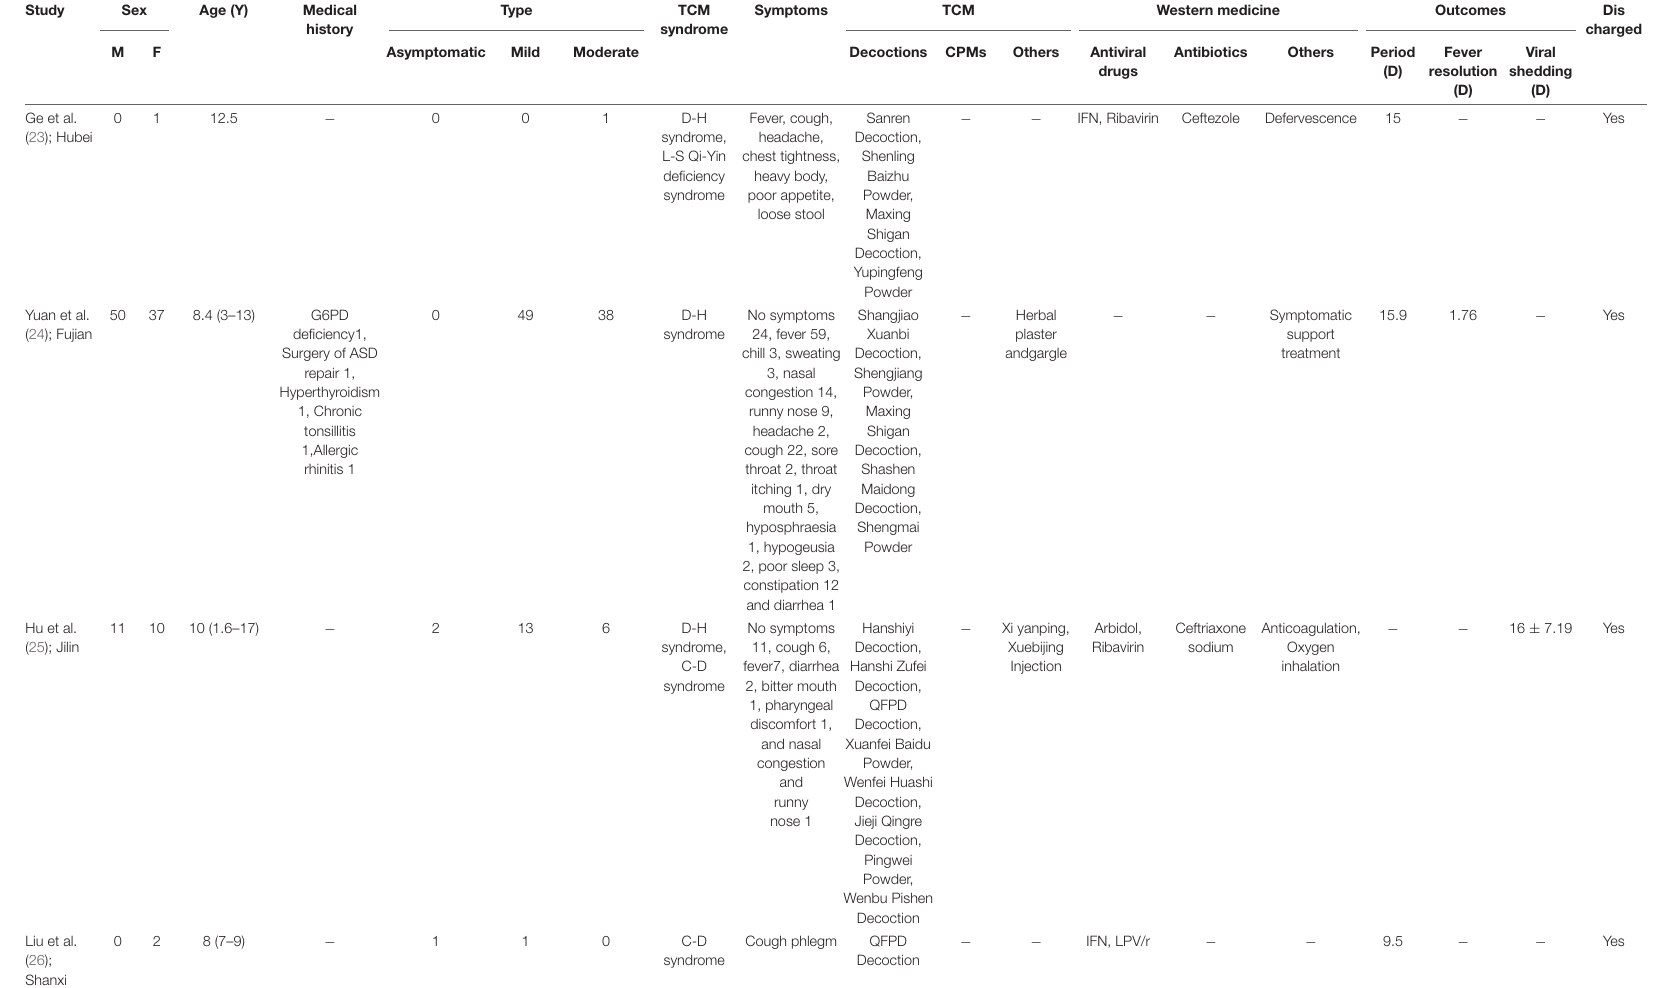
TABLE 1 | Characteristics of 19 retrospective studies on children with COVID-19.